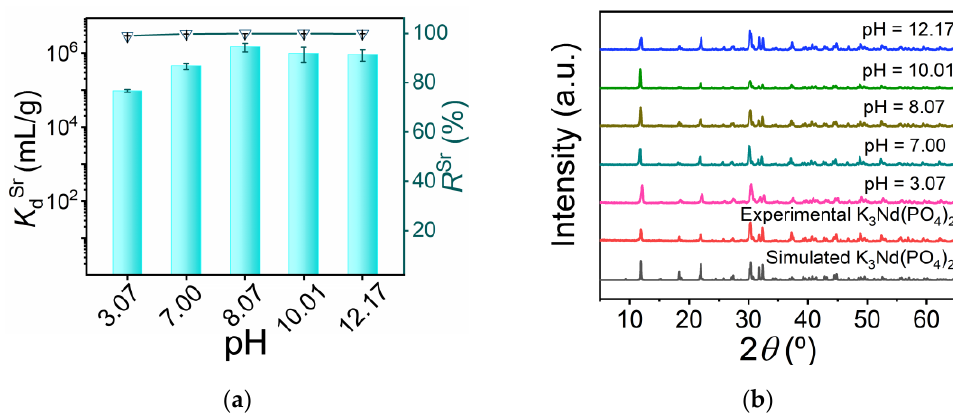
Figure 3. ( a ) The effect of different pH on the Sr 2+ adsorption of K 3 Nd(PO 4 ) 2 studied by plotting the relationship of K dSr (mL/g) (column) and R Sr (line chart) vs. pH values ; ( b ) PXRD patterns of the K 3 Nd(PO 4 ) 2 samples before and after Sr 2+ adsorption in the pH range from 3.07 to 12.17. Table 2. The comparison of the adsorption abilities of K 3 Nd(PO 4 ) 2 and other reported adsorbents for Sr 2+ .